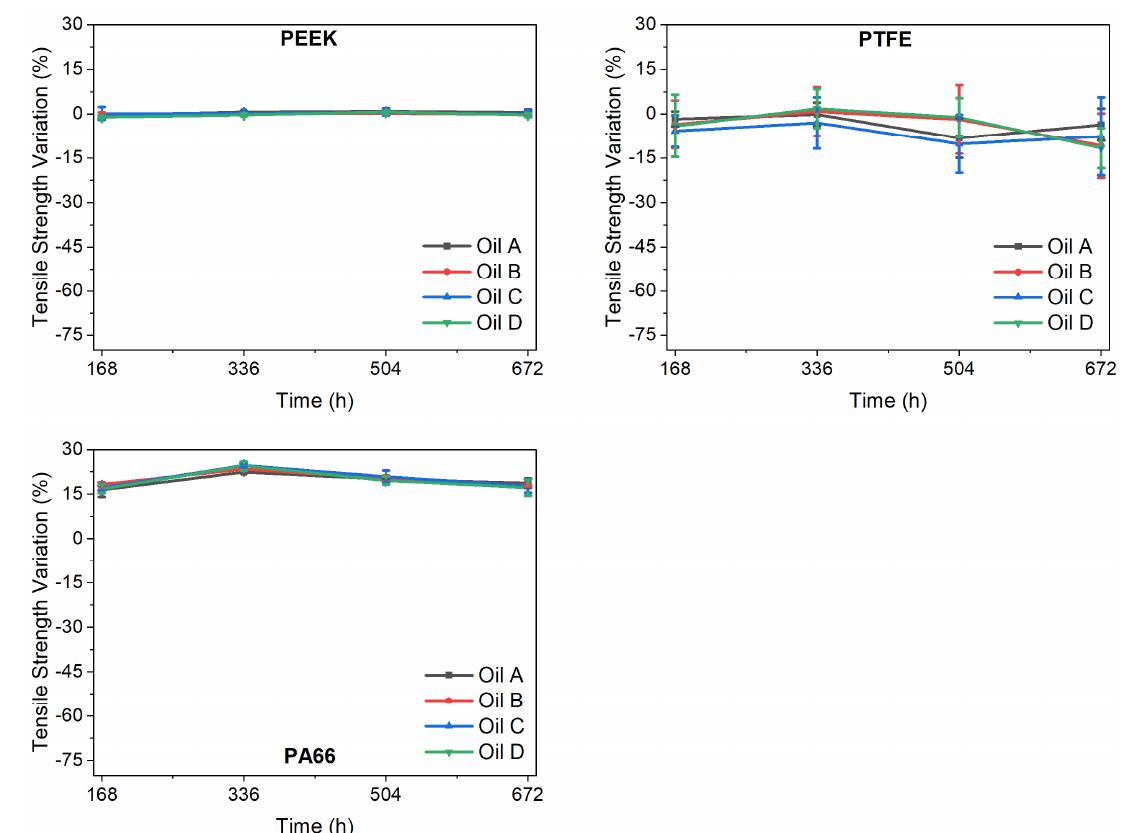
Figure 3. Changes in tensile strength of PEEK, PTFE, and PA66 after ageing in the ATFs. The elongation at break was more affected by the ageing process than was the tensile strength (Figure 4). In the case of PEEK, variations in elongation at break depended on the ATF used and were between +7% and − 15% at 168 h. On the contrary, the PTFE results are aligned with those of tensile strength, with variations in the elongation at break values of between − 2 and − 7%. Once again, PA66 had contrasting results, with a reduction in elongation at break of around 77%, regardless of the ATF used. This is a clear sign of incompatibility, as the material became less flexible, and thus more fragile.